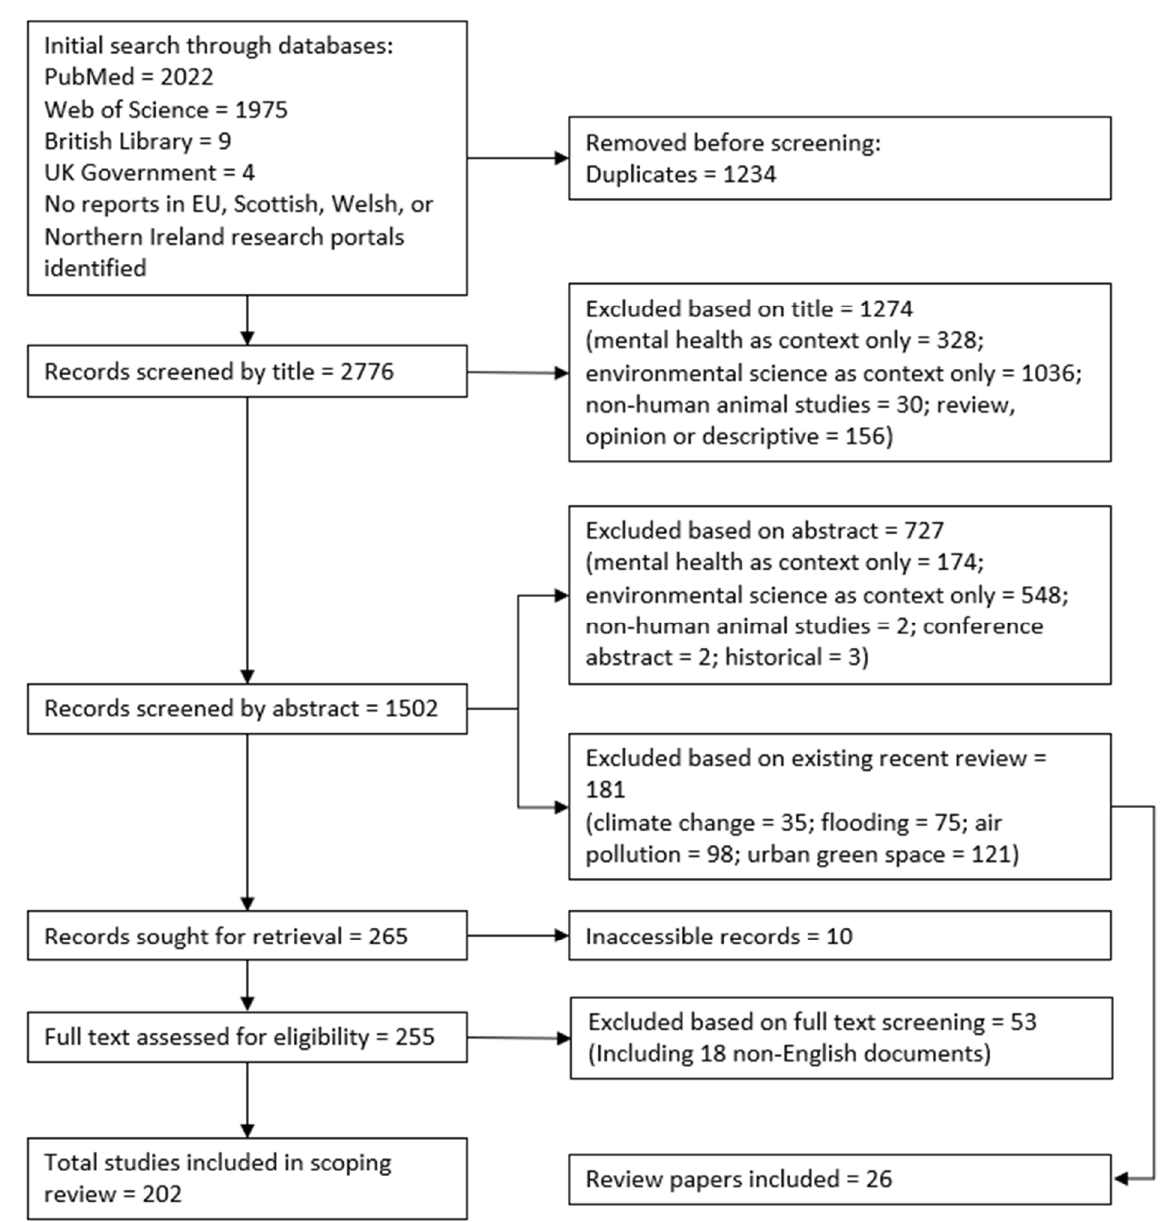
Figure 1. Screening record of scoping review and review papers. Review papers were excluded from the scoping review but retained for separate consideration where they concerned climate change, flooding, air pollution, and urban green space.